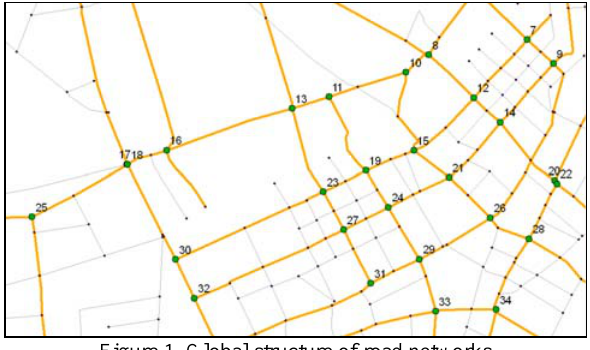
Figure 1. Global structure of road networks